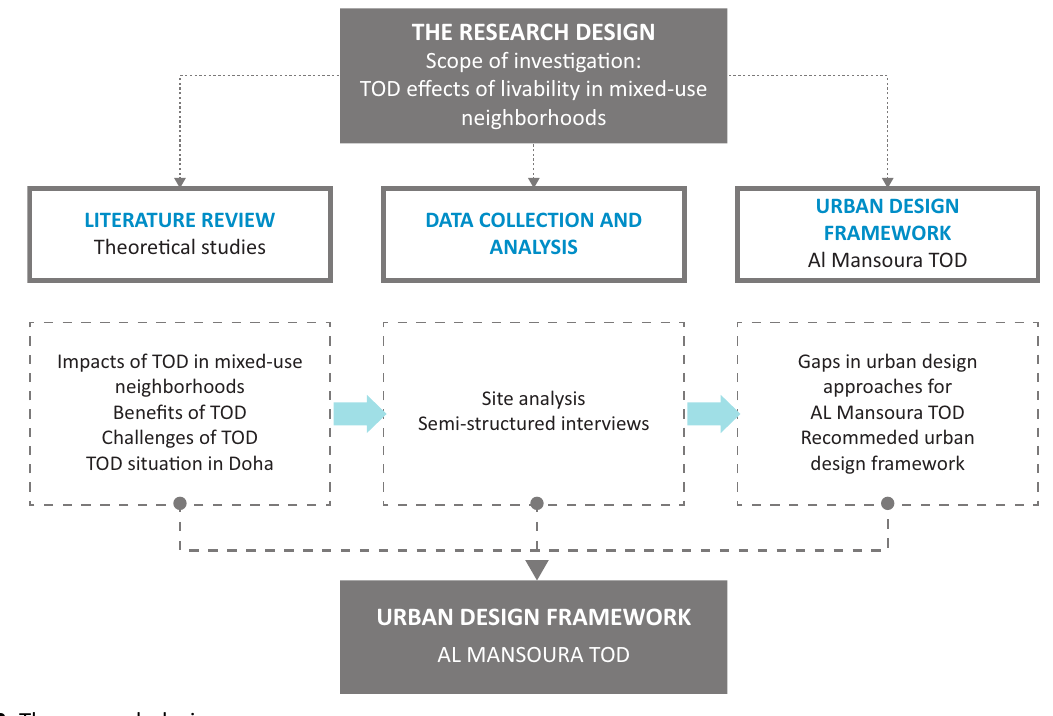
Figure 2. The research